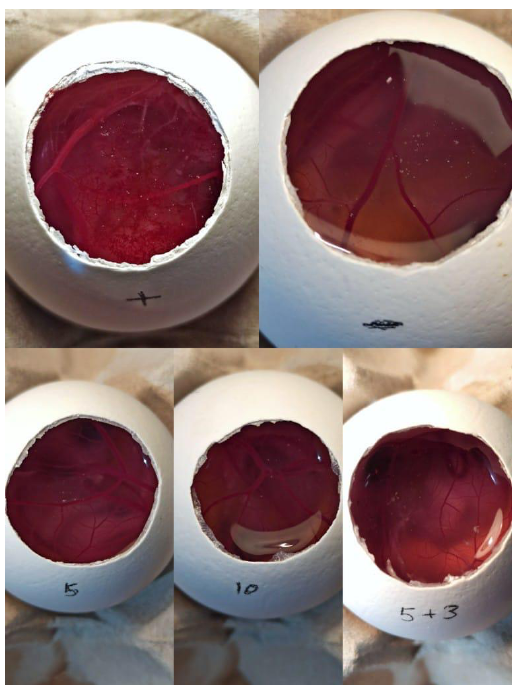
Figure 1. Photograph of the hen’s egg-choriollantoic membrane test (HET-CAM) test results to evaluate the irritancy of glutathione (GSH) solutions. In clockwise direction, positive (0.1 N NaOH) and negative (0.9% NaCl) controls, 5 mg/mL and 10 mg/mL GSH solutions, and 5 mg/mL GSH containing 3 mg/mL Vit C.